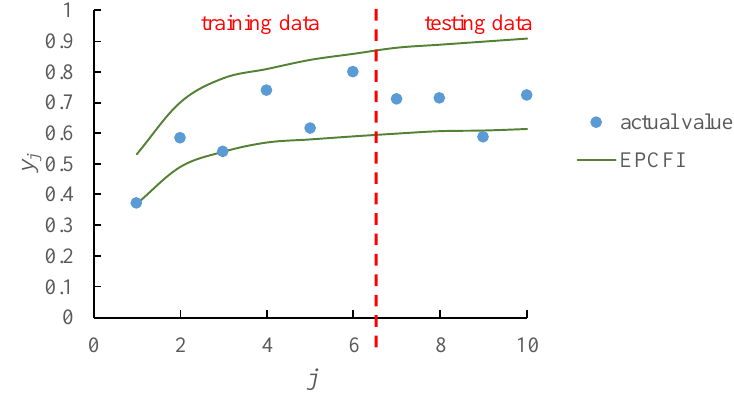
Figure 8. Example EPCFI diagram for Period 1.